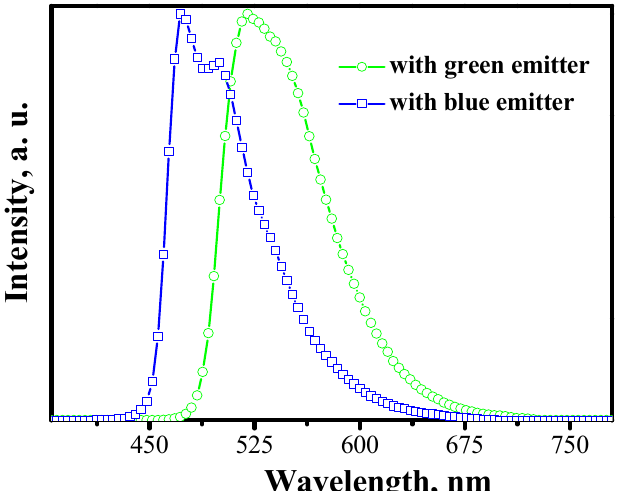
Figure 4. EL spectra of the OLEDs with host material H1 with blue FIrpic or green Ir(ppy) 3 dopants in emitting